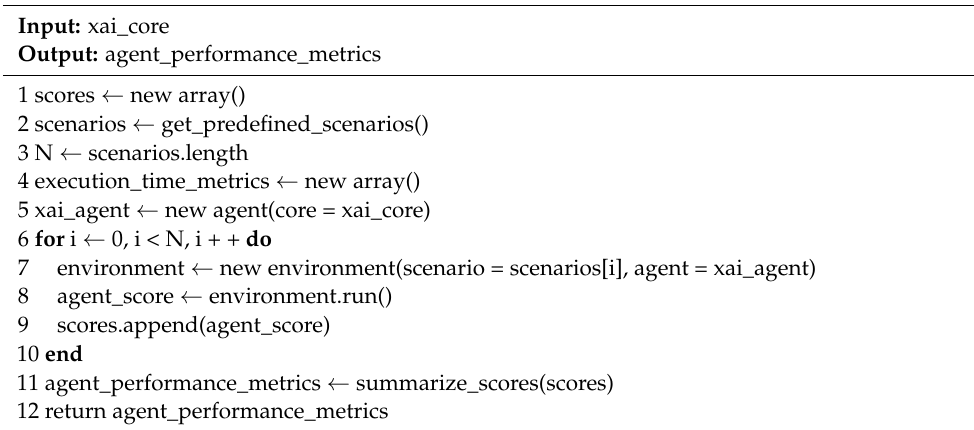
Algorithm 4: XAI Agent Benchmark using a given XAI